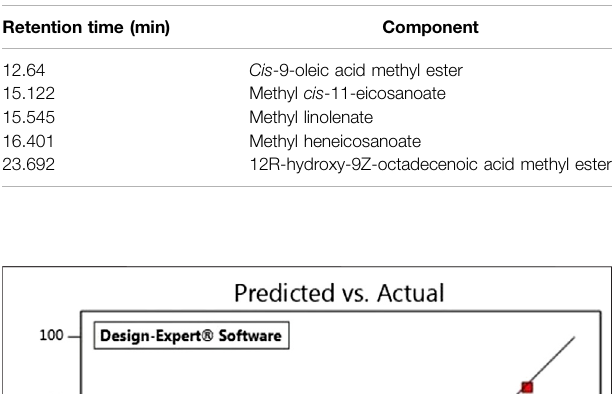
TABLE 5 | Gas chromatography analysis results